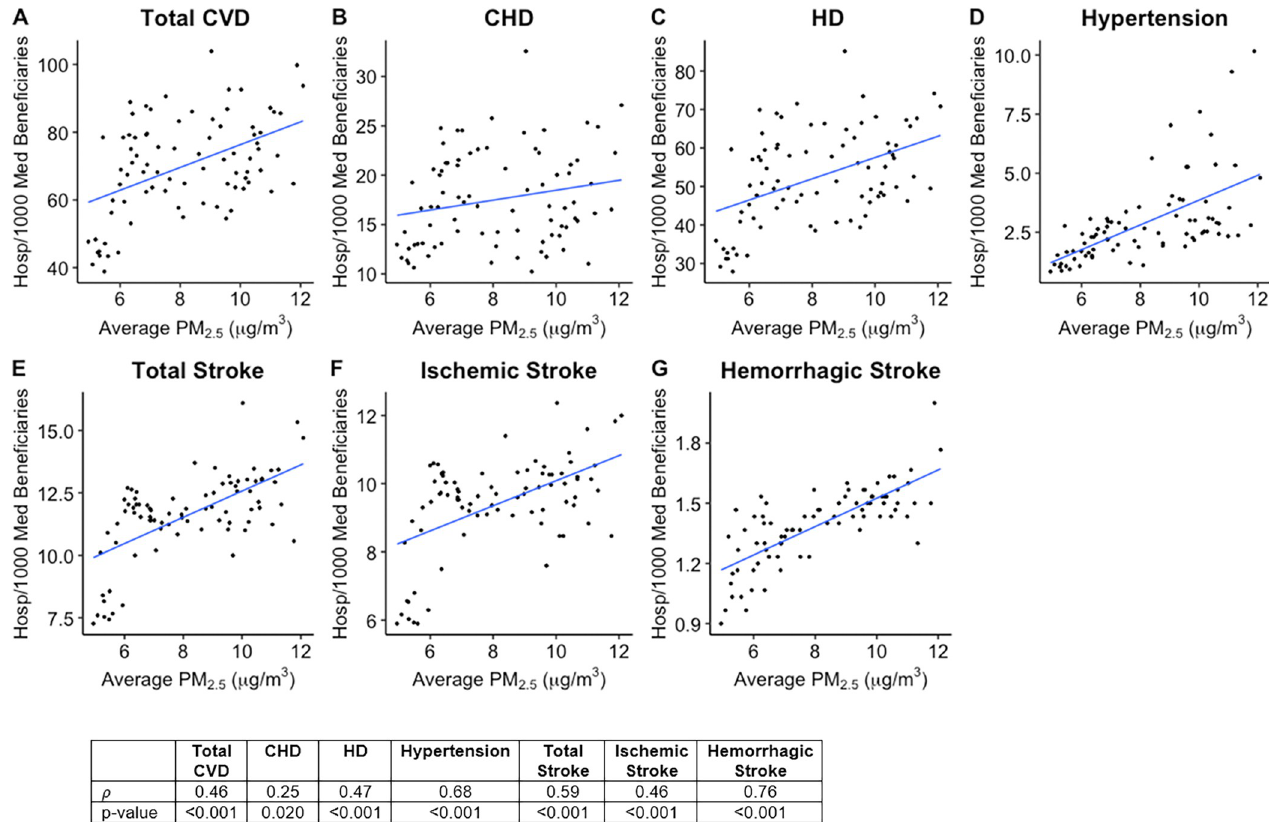
Fig 1. Scatterplots showing average PM 2.5 (x axis) vs. Hospitalizations (y axis) for: A. Total Cardiovascular Disease (CVD), B. Coronary Heart Disease (CHD), C. Heart Disease (HD), D. Hypertension, E. Total Stroke, F. Ischemic Stroke, G. Hemorrhagic Stroke. Hospitalizations have units: Disease hospitalizations per 1000 Medicare beneficiaries (ages 65+) within the county. Individual points represent average values for each of the 82 counties included in the study. Best fit line for each plot was obtained by simple linear regression. Table shows Spearman rank correlation coefficient ( ρ ) calculated for each plot as well as the p-value for each correlation coefficient. P-values < 0.05 are statistically